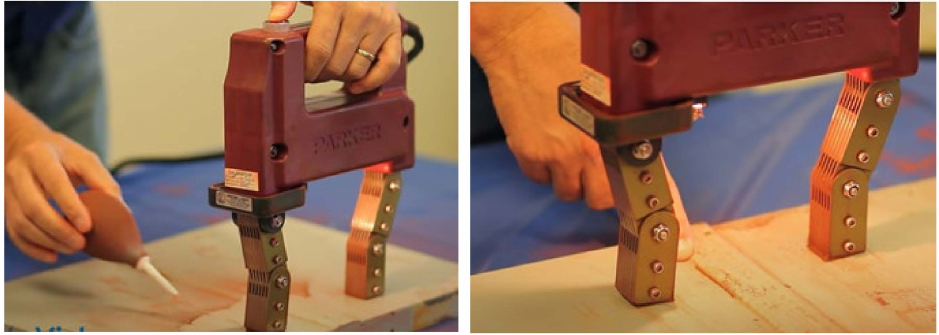
Figure 7. Application of dry MT (Alta Vista